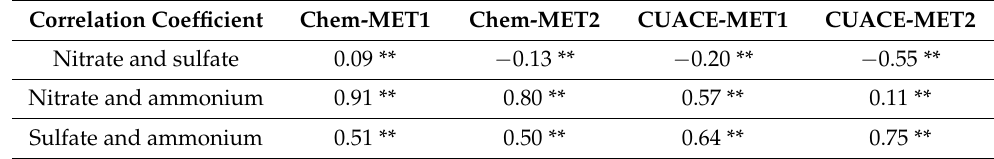
Table 8. Correlations of nitrate, sulfate and ammonium in the proportion of PM 2.5 in the four tests. Correlation Coefficient Chem-MET1 Chem-MET2 Nitrate and